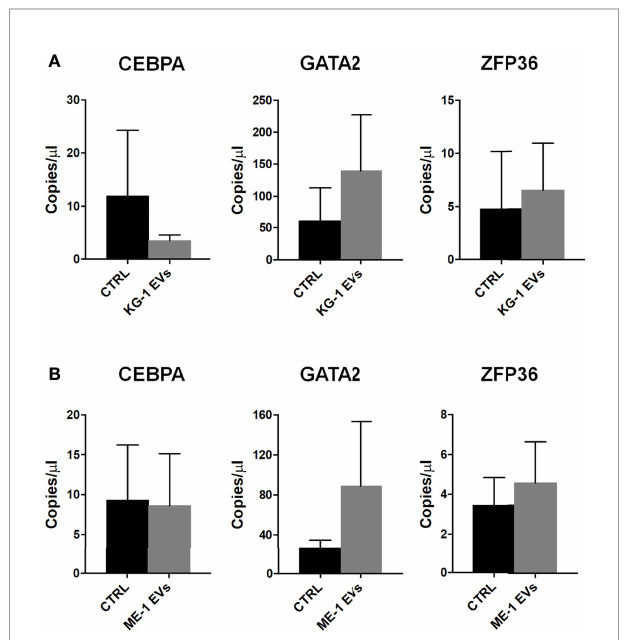
FIGURE 5 | Hematopoiesis related mRNAs in HSPCs treated with AML-EVs. Absolute quanti fi cation (copies/ m L) by ddPCR of CEBPA , GATA2 and ZFP36 mRNAs in HSPCs treated and not (CTRL) with KG-1 EVs (A) or ME-1 EVs (B) . Values represent results from three independent experiments (p >